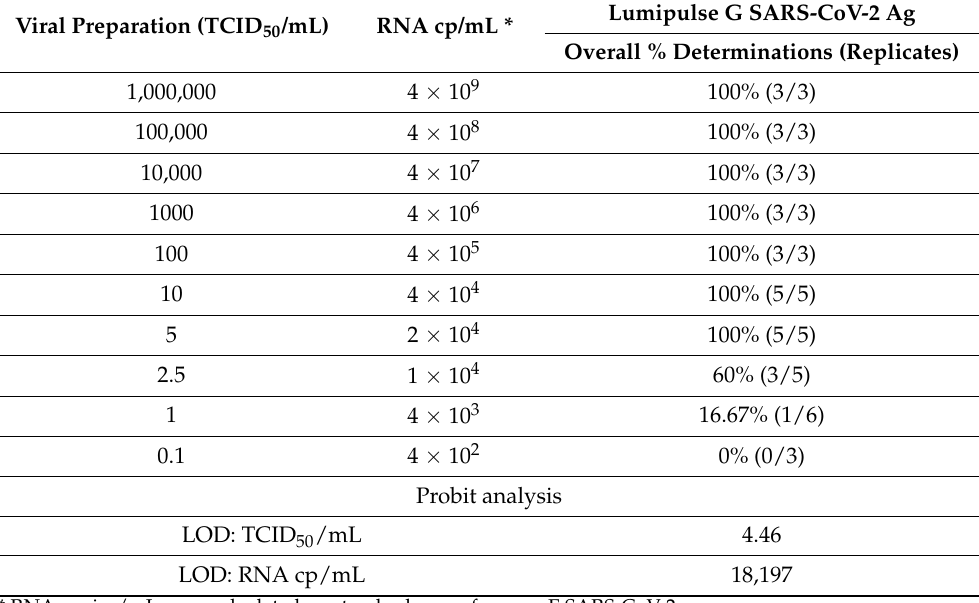
Table 2. Analytical sensitivity (LOD) was determined with spiked SARS-CoV-2 on a saliva matrix from healthy donors by Probit